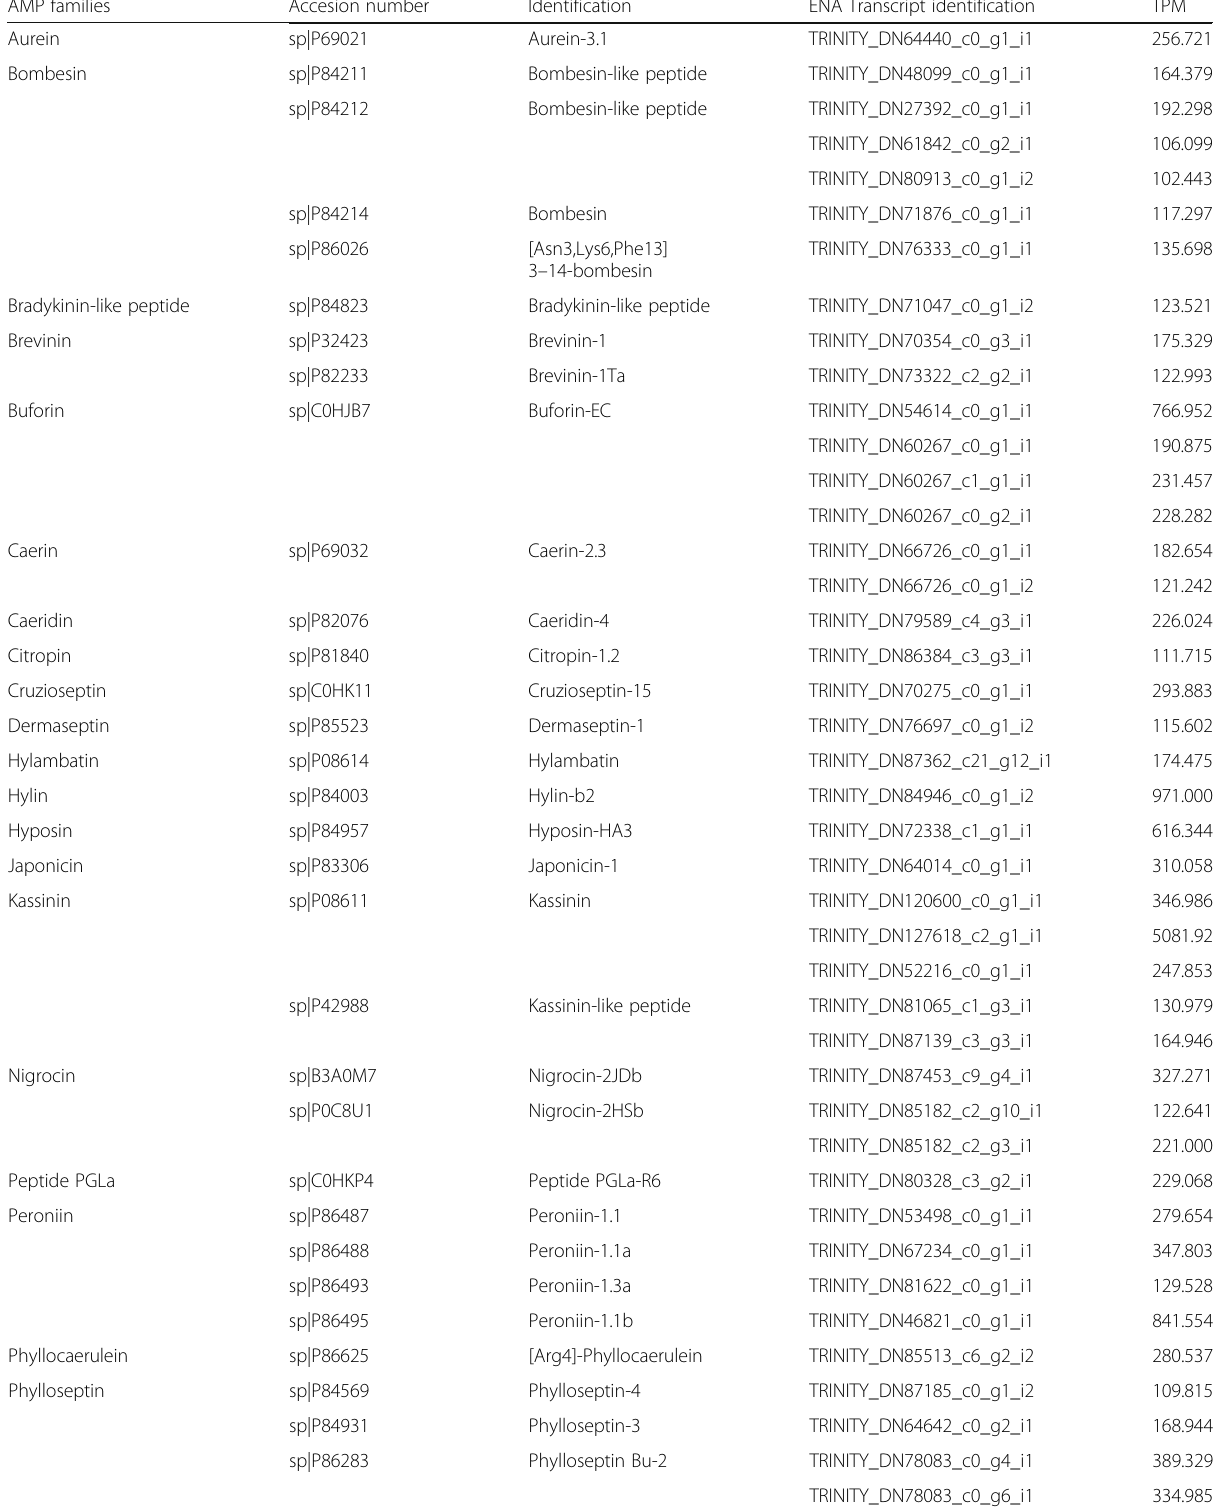
Table 2 List of main antimicrobial peptides from